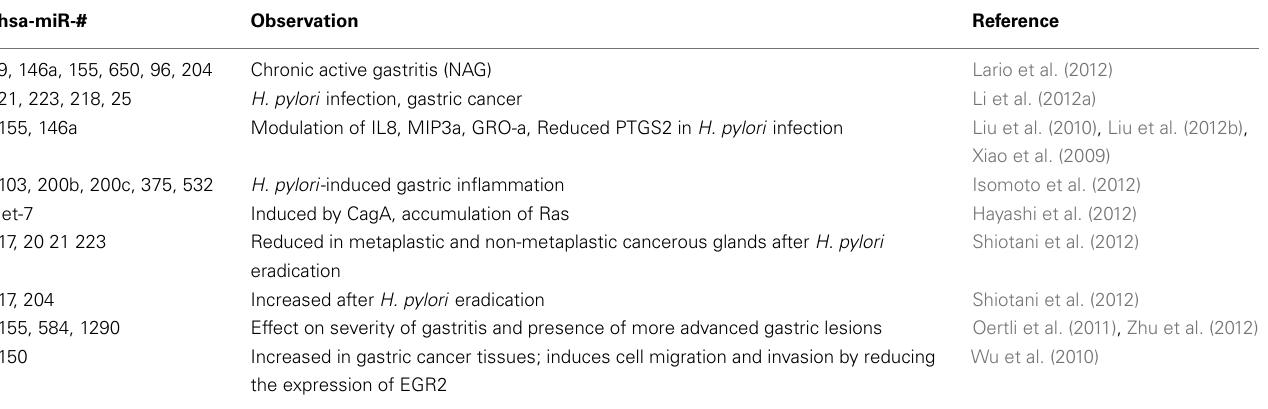
Table 1 |Association of several miRNA with gastric lesions, from H. pylori infection to gastric